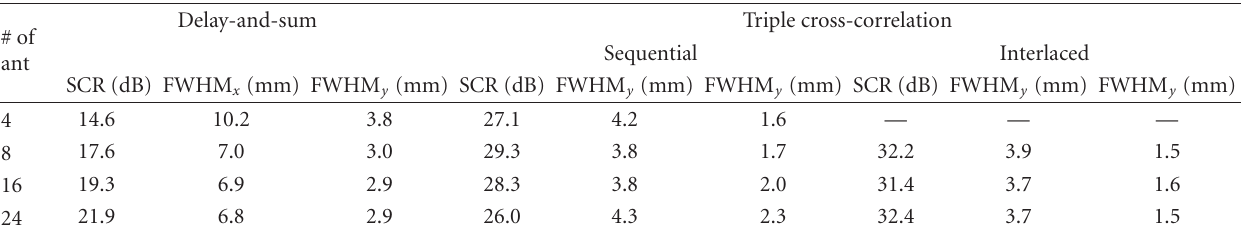
Table 3: Same as Table 2 for numerical